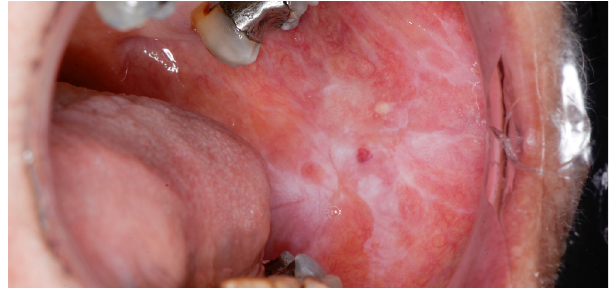
Fig. 6. White lichenoid striations with background erythema involving the left buccal mucosa consistent with oral lichen planus (mild dysplasia on histology) (image provided by Guy ’ s and St Thomas ’